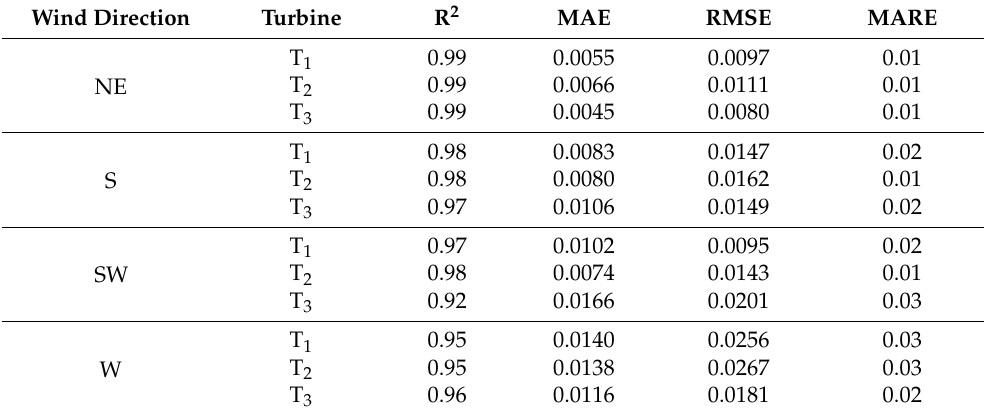
Table 2. Statistical error indices of the CNN DA relative to the LES results for different wind direc- tion